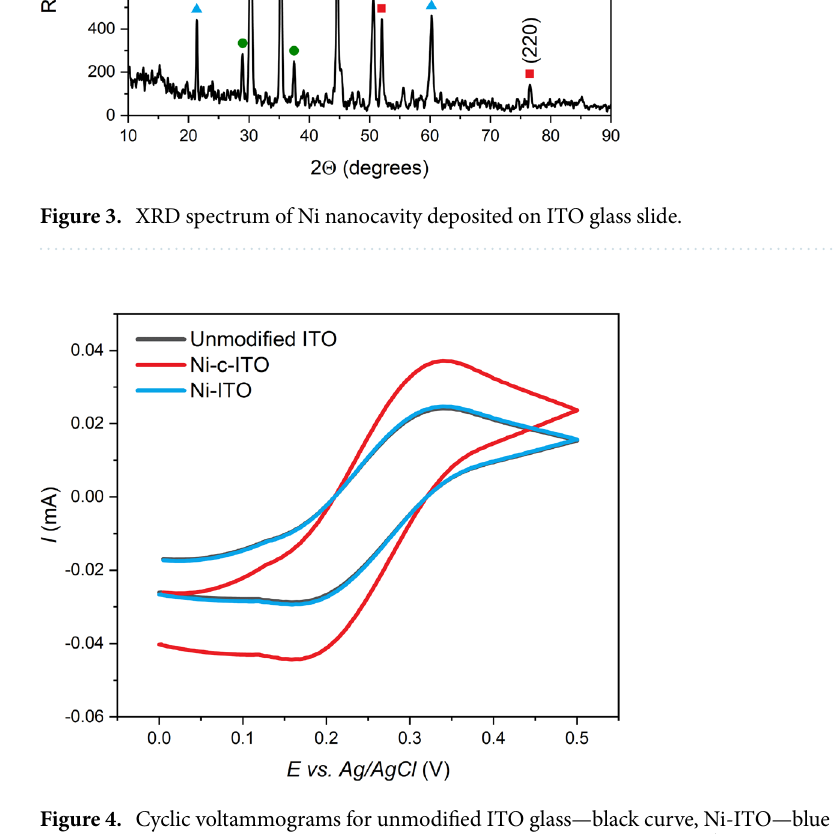
Figure 4. Cyclic voltammograms for unmodified ITO glass—black curve, Ni-ITO—blue curve, and Ni-c- ITO—red curve in 5 mM K 3 [Fe(CN) 6 ]/K 4 [Fe(CN) 6 ] in 1 M KCl at 50 mV s −1